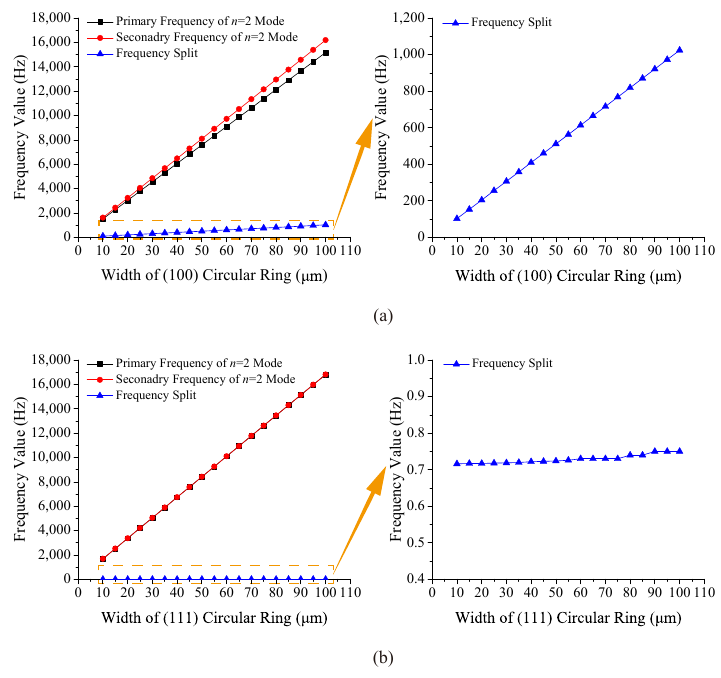
Figure 3. Resonant frequencies and frequency splits of rings with different widths: ( a ) (100) ring, ( b ) (111)